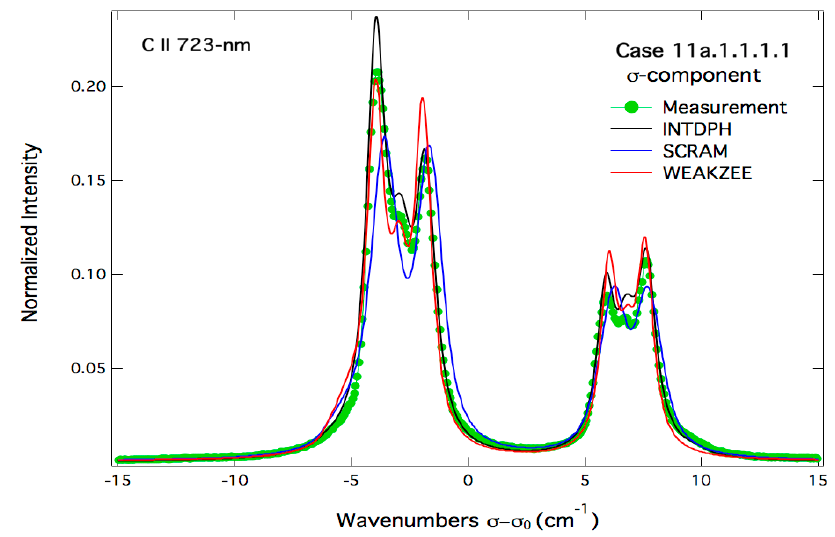
Figure 9. Fitting attempts of the σ -polarized experimental spectrum of the C II 723-nm line as measured in LHD. All spectra are normalized to unity.